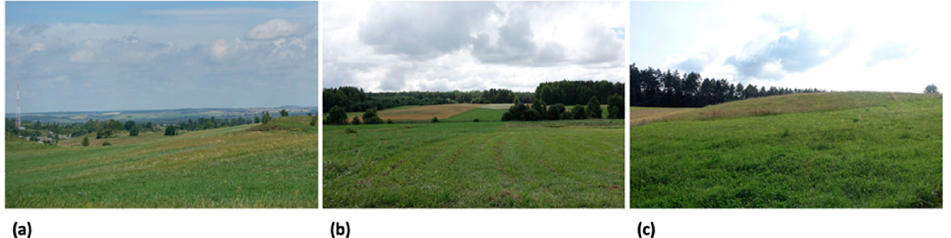
Figure 2. Typical landscapes of the ( a ) Belarusian, ( b ) Lithuanian, and ( c ) Polish parts of the studied border area. Credit: J.P., 2018–2019.